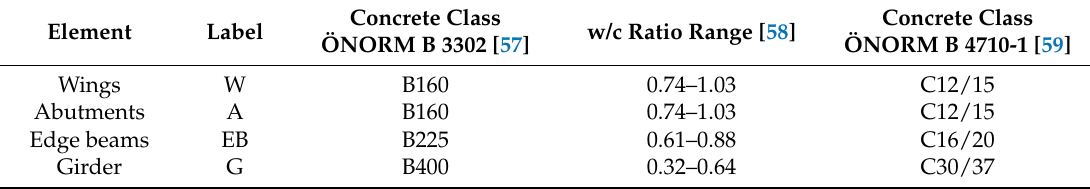
Table 11. Prescribed w/c ratios in connection to concrete classes and cement strength classes [58].